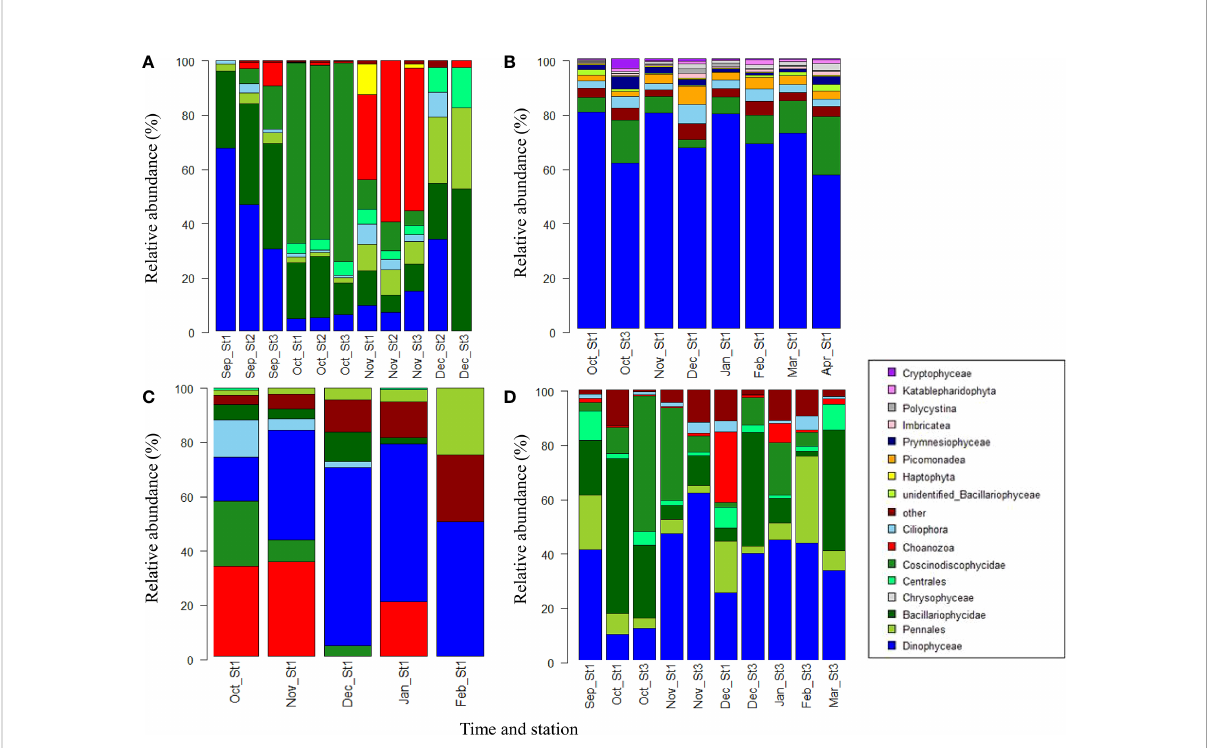
FIGURE 9 Protist community structures. Most abundant taxa (primarily in classes) in (A) phytoplankton net samples (Net), (B) 18S sequencing samples, (C) water samples at 5 m, and (D) water samples at 30 m. The sample origins are indicated at the bottom label. Months are indicated by the fi rst three letters of their